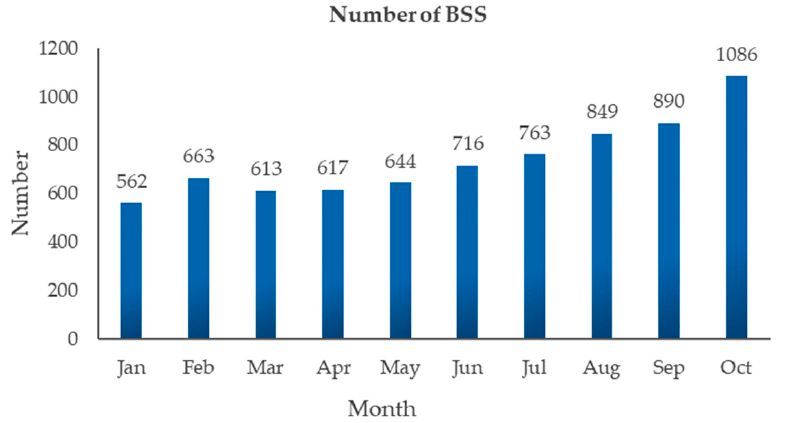
Figure 8. Number of BSS in China from January to October 2021. Data source: China Electric Vehicle Charging Infrastructure Promotion Alliance.